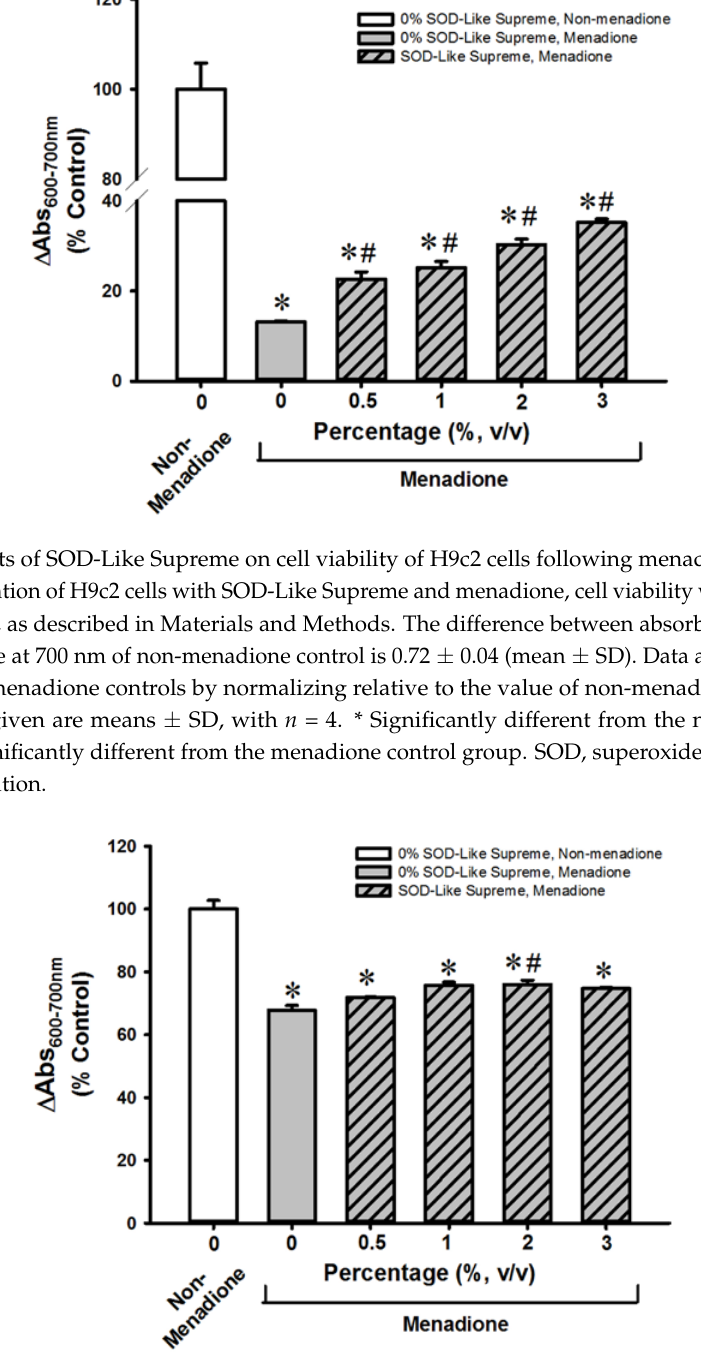
Figure 2. Effects of SOD-Like Supreme on cell viability of AML12 cells following menadione challenge. After the co-incubation of AML12 cells with SOD-Like Supreme and menadione, cell viability was assessed by the MTT assay, as described in Materials and Methods. The difference between absorbance at 600 nm and absorbance at 700 nm of non-menadione controls is 1.10 ± 0.03 (mean ± standard error of the mean (SEM) Data are expressed as % of the non-menadione controls by normalizing relative to the value of the non-menadione-incubated cells. Values given are means ± SEM, with n = 8. * Significantly different from the non-menadione controls; # Significantly different from the menadione control group.